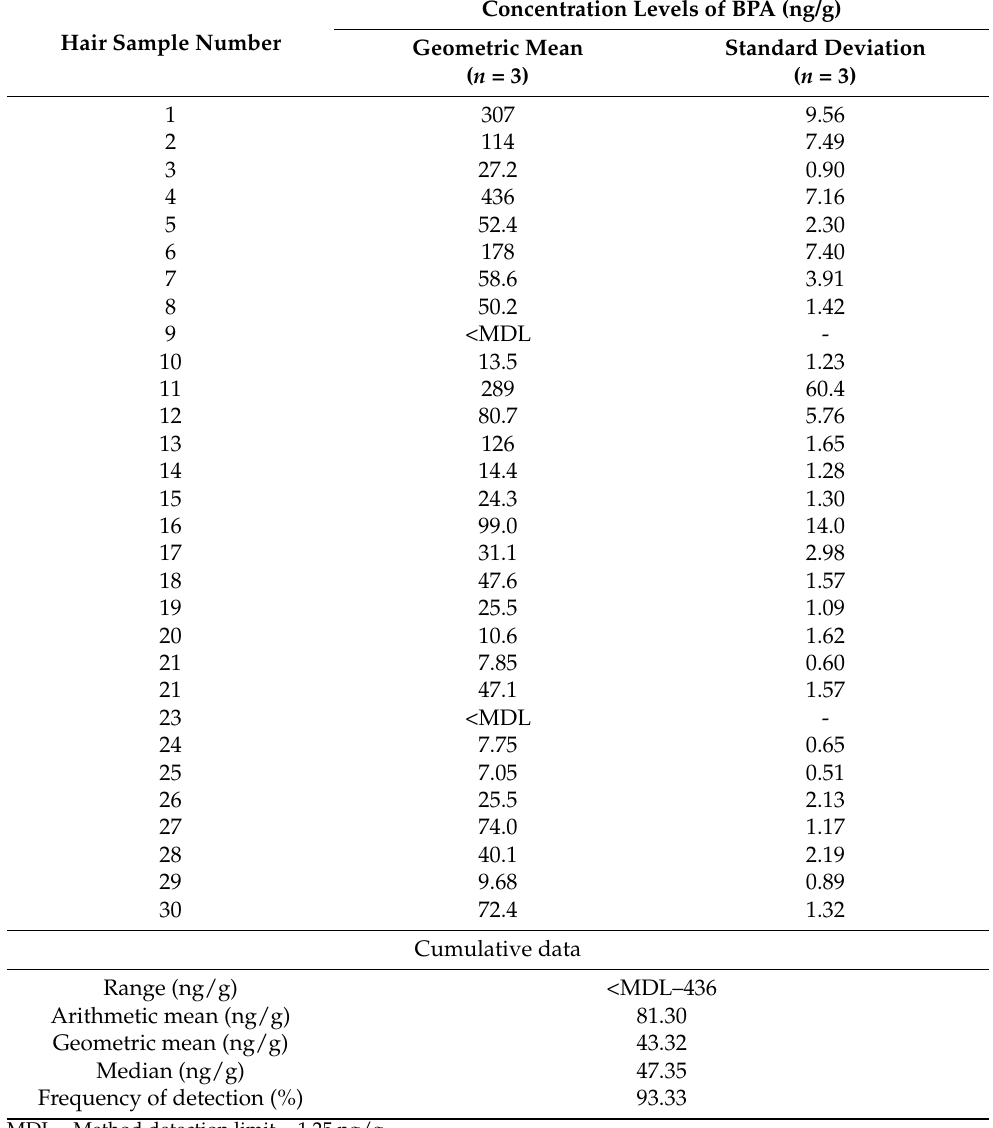
Concentration Levels of BPA